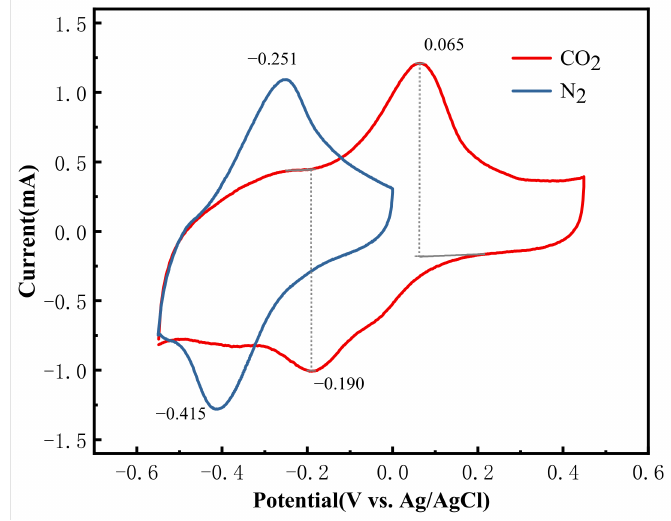
Figure 8. Cyclic voltammograms of PAQ/MWCNTs composite electrodes in nitrogen and carbon dioxide.